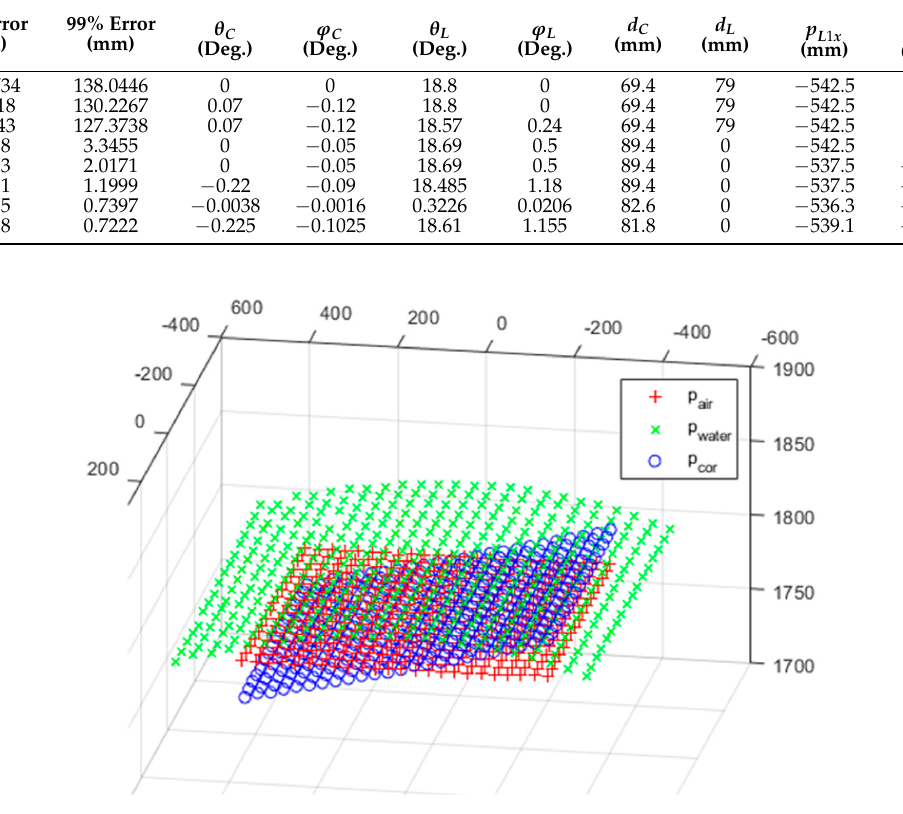
Figure 22. Initial error of refraction correction. Table 3. Parameter study.